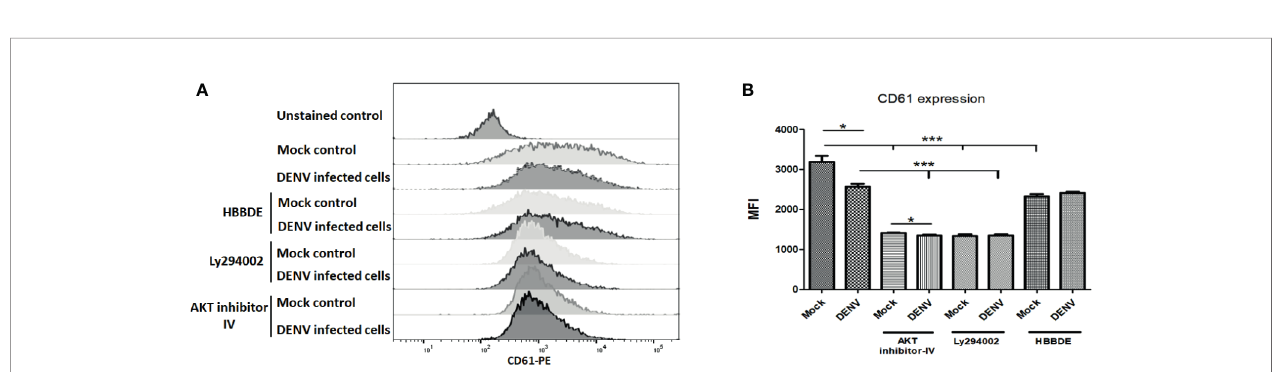
FIGURE 6 | Flow cytometry of CD61 in mock and DENV infected MEG-01 cells. MEG-01 cells were mock-treated or treated with inhibitors of AKT (AKT-IV), PI3K (Ly294002), and PKC a (HBBDE). (A) Histograms from different conditions represent the expression of CD61 and (B) column graph presentation of median fl uorescence intensity (MFI) of CD61 in cells with the above-stated condition. (*pValue < 0.05; ***pvalue < 0.001).